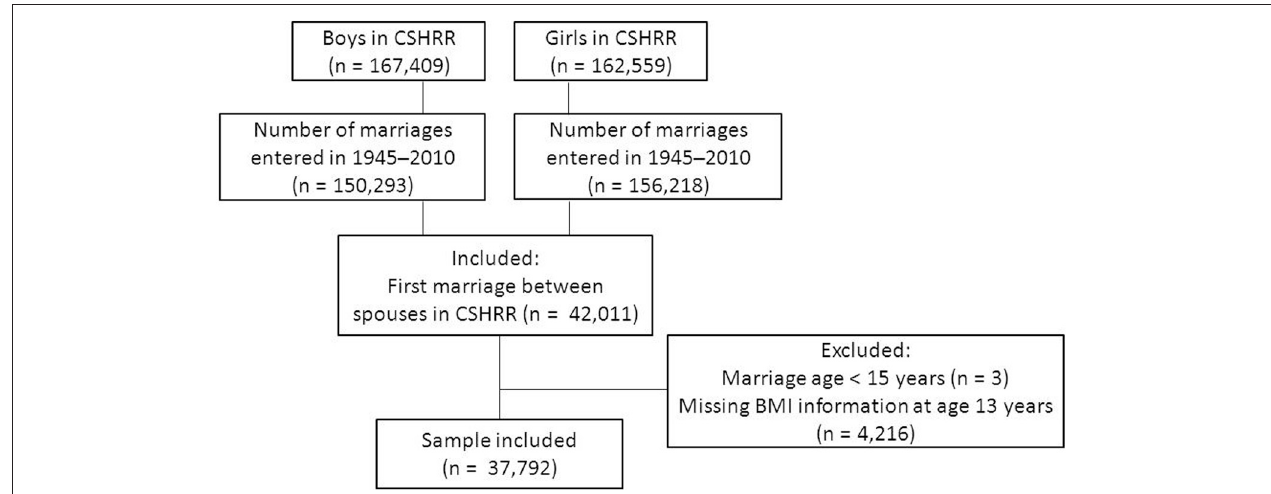
FIGURE 1 | Flowchart of the study